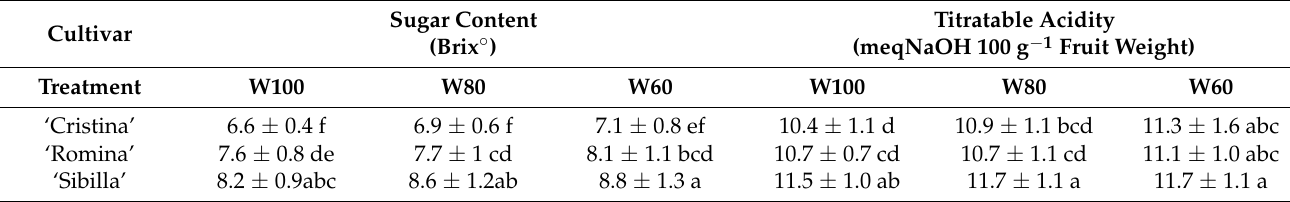
Table 13. Effects of water availability on sugar content and titratable acidity in different strawberry cultivars. Values with the same lowercase letter for the same parameter were not statistically different for Fisher’s LSD test ( p < 0.05). Values are expressed as means of two years (2017–2018) ± standard deviation (SD).